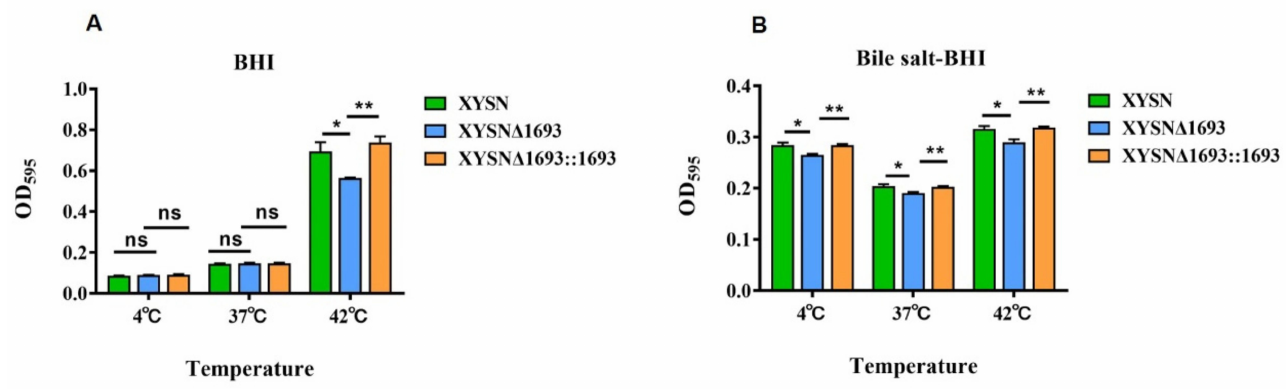
Figure 3. LMxysn_ 1693 gene contributes to biofilm formation. A quantity of overnight bacterial cultures was added into a sterile 96-well for 72 h at 37 ◦ C. The level (OD) of the crystal violet present in destaining solution was measured at 595 nm in BHI medium at 4 ◦ C, 37 ◦ C and 42 ◦ C ( A ), bile salt-BHI medium at three temperatures ( B ). Each strain was tested in triplicate. They were determined by Student’s t -test: ns, no significance; * p < 0.05, ** p <